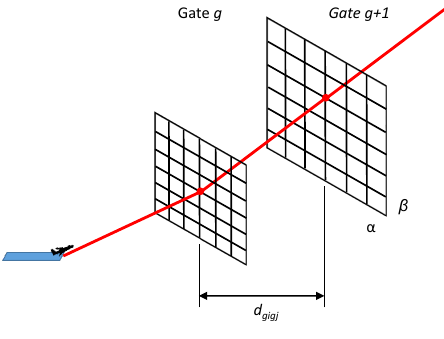
Figure 6. Simplified 3D funnel grid for two rectangular gates g and g + 1 with α = 6 lateral and β = 6 vertical sections, resulting in 49 grid points for each